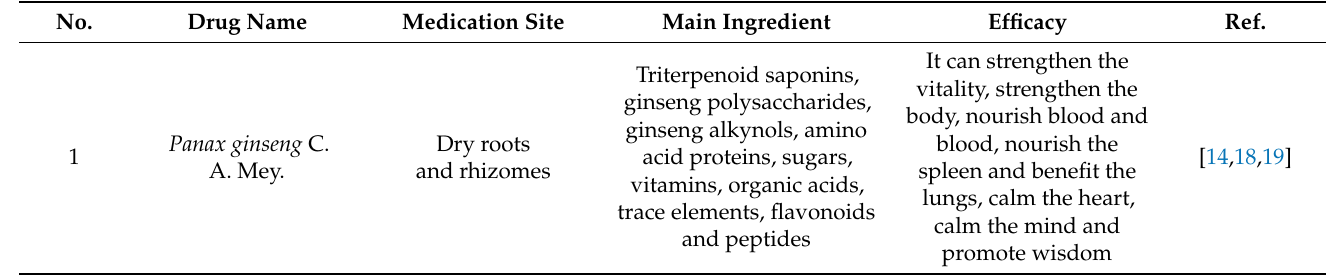
Table 1. Efficacy table of Chinese medicinal materials mainly containing